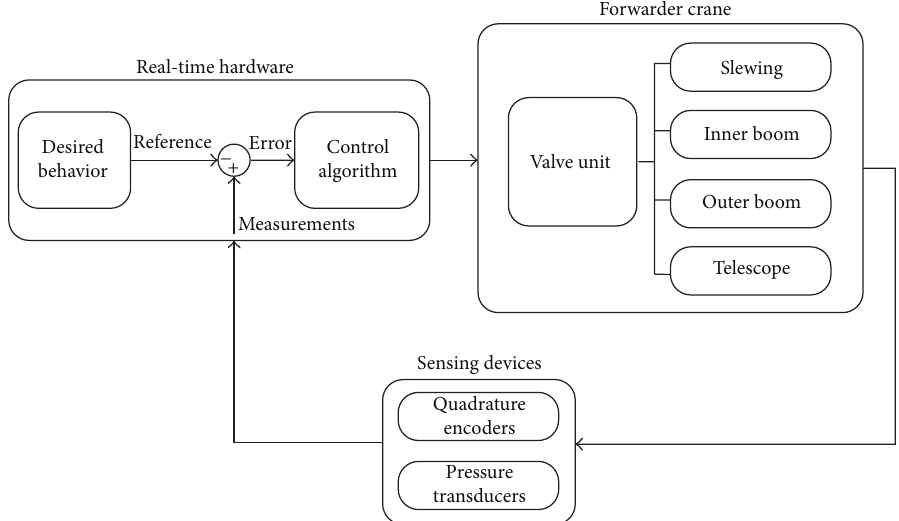
Figure 5: The layout presents the configuration of our control system setup, which includes the measurement devices and the rapid prototyping unit. The valve is equipped with magnetic coils to provoke the motion of the internal spools and a power amplifier that accepts regular PWM